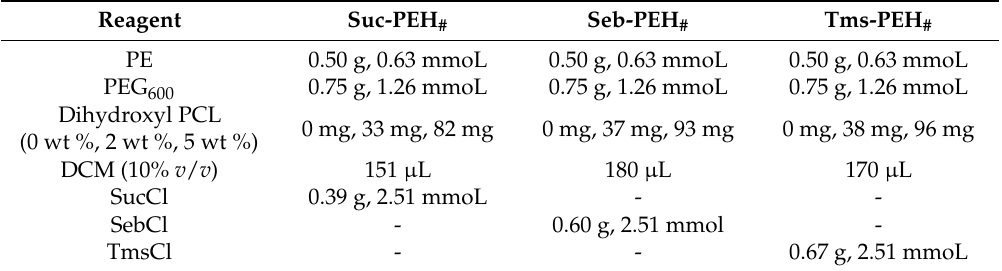
Table 1. Reagent quantities for the preparation of Suc-PEHs, Seb-PEHs, and